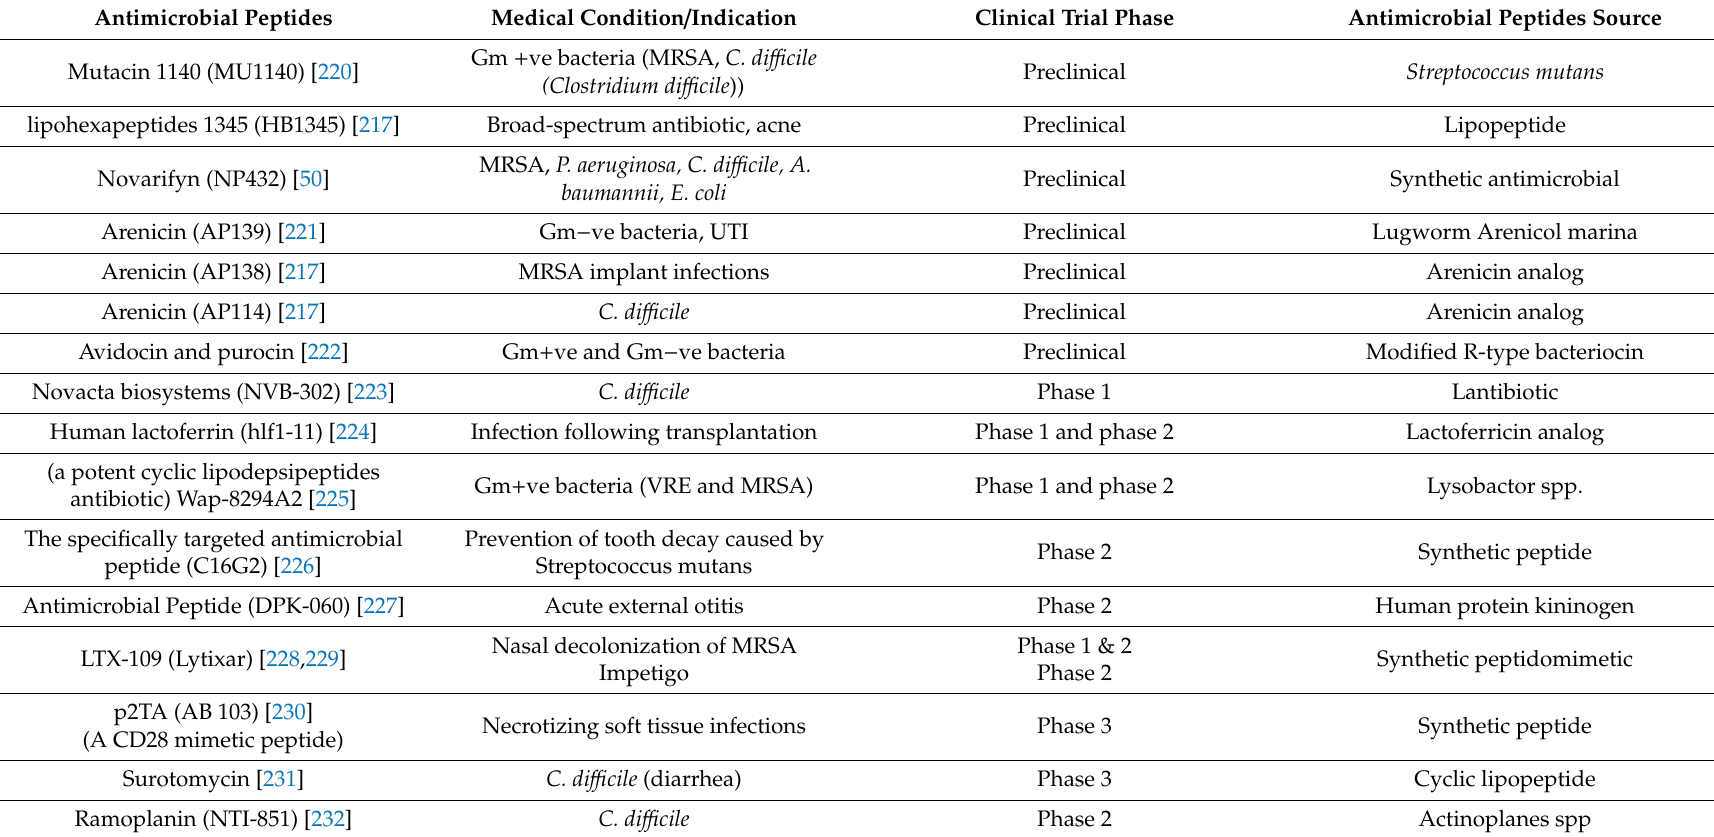
Table 6. Nanosystem-based antimicrobial peptides in clinical trials di ff erent